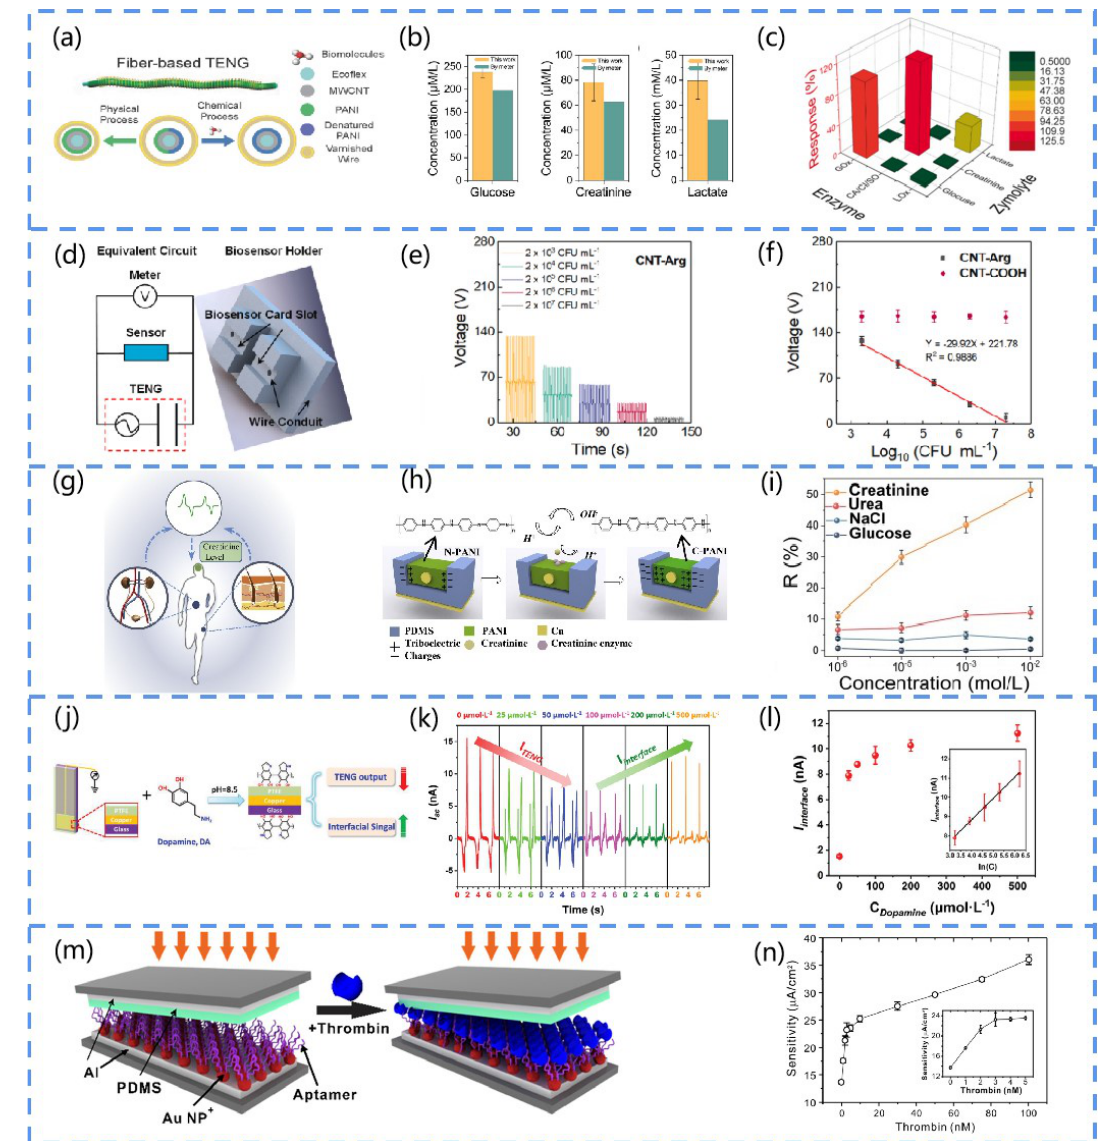
Figure 13. ( a ) Schematic diagram of the fiber structure of the F-TENG. ( b ) Schematic diagram of the comparative biosensitivity of the F-TENG and commercial sensors for glucose, creatinine, and lactate. ( c ) Selectivity of the TENG for the detection of glucose, lactate, and creatinine. Reprinted from [94] with permission from Elsevier. ( d ) Schematic diagram of the TENG-based biosensing system and its equivalent circuit. ( e ) Voltage of CNT-Arg under a range of concentrations of S. aureus (2 × 10 3 CFU mL −1 to 2 × 10 7 CFU mL −1 ). ( f ) Linear fit of the response of S. aureus from 2 × 10 3 to 2 × 10 7 CFU mL −1 concentrations. Reprinted from [95] with permission from Elsevier. ( g ) TENG-based sensing system detects creatinine in body fluids. ( h ) The protonation and deprotonation process of PANI and its sensing mechanism. ( i ) The response of the sensor to creatinine. Reprinted from [97] with permission from Elsevier. ( j ) Schematic diagram of dopamine coated on the surface of a liquid–solid TENG electrode. ( k ) Schematic diagram of the short-circuit current of the TENG modified by dopamine in an oil/water environment. ( l ) Plot of I interface and I-TENG versus dopamine concentration in an oil/water environment. Reprinted from [98] with permission from Wiley Online Library. ( m ) Schematic diagram of thrombin detection by the TENG biosen- sor. ( n ) Detection sensitivity of the TENG-based biosensor. Reprinted from [101] with permission from